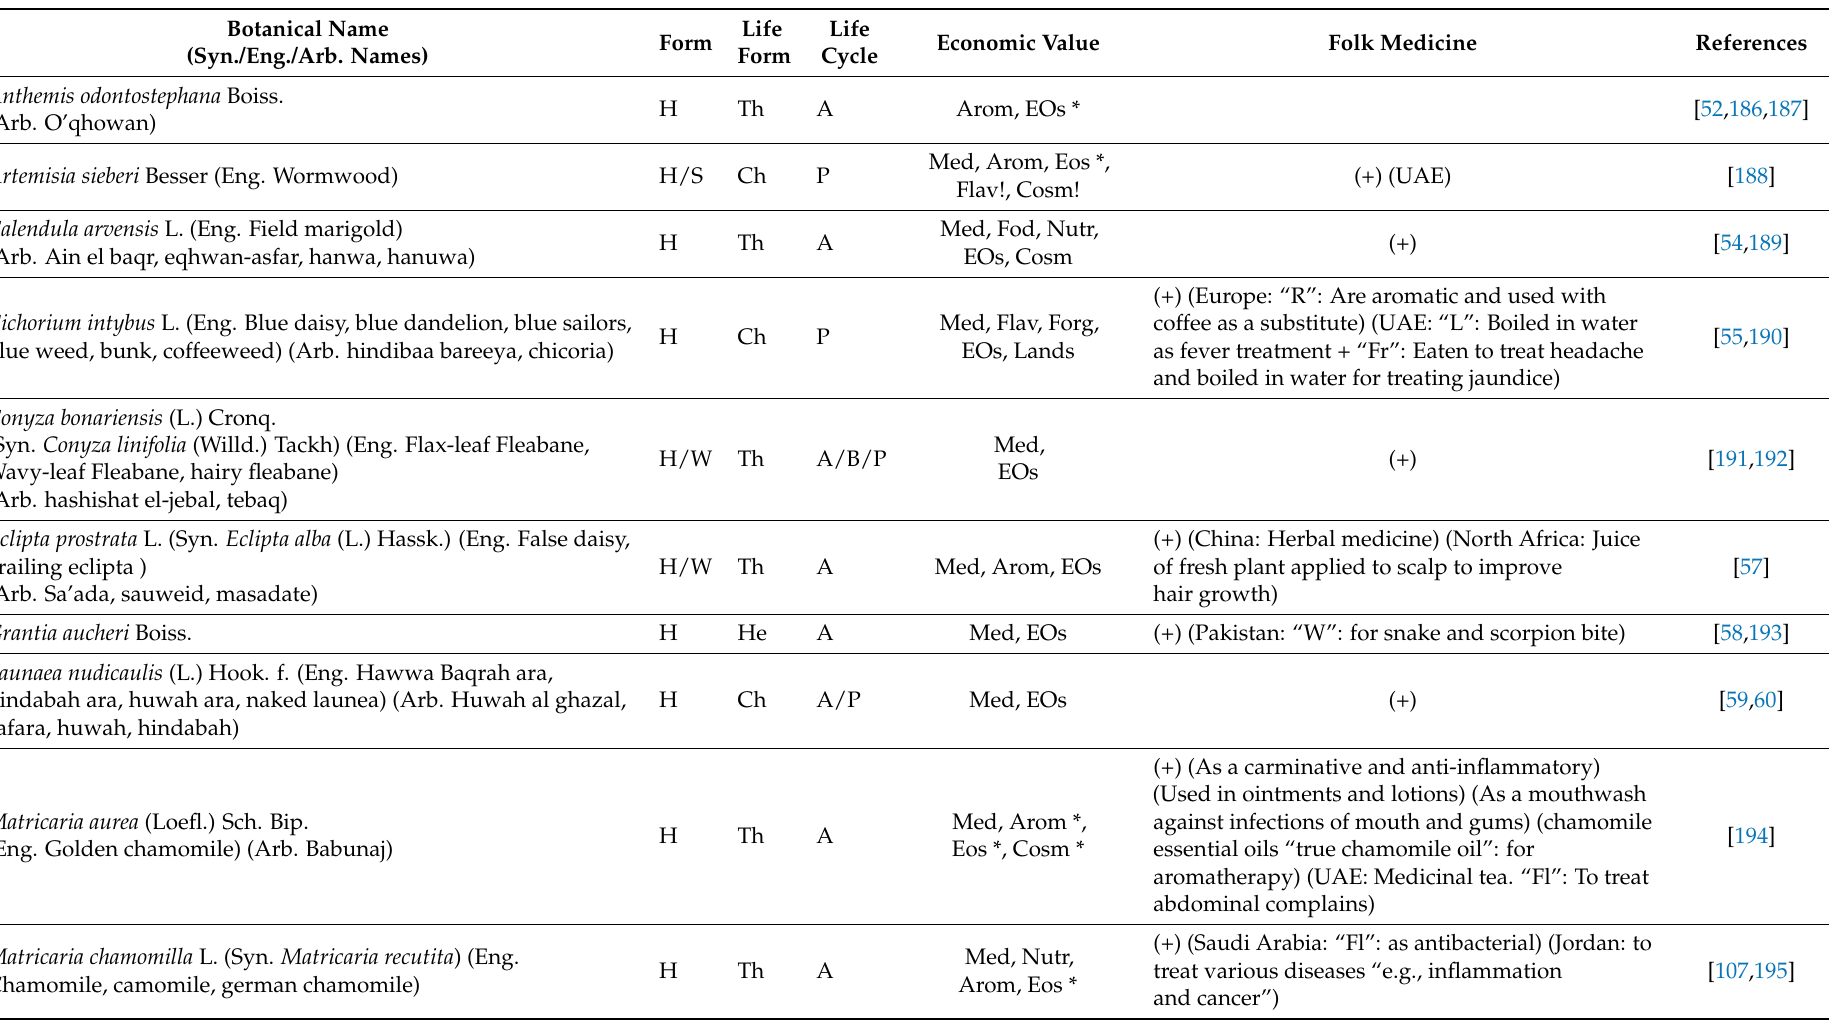
Table 2. The UAE EO-bearing species of Asteraceae/Compositae/Anthemideae